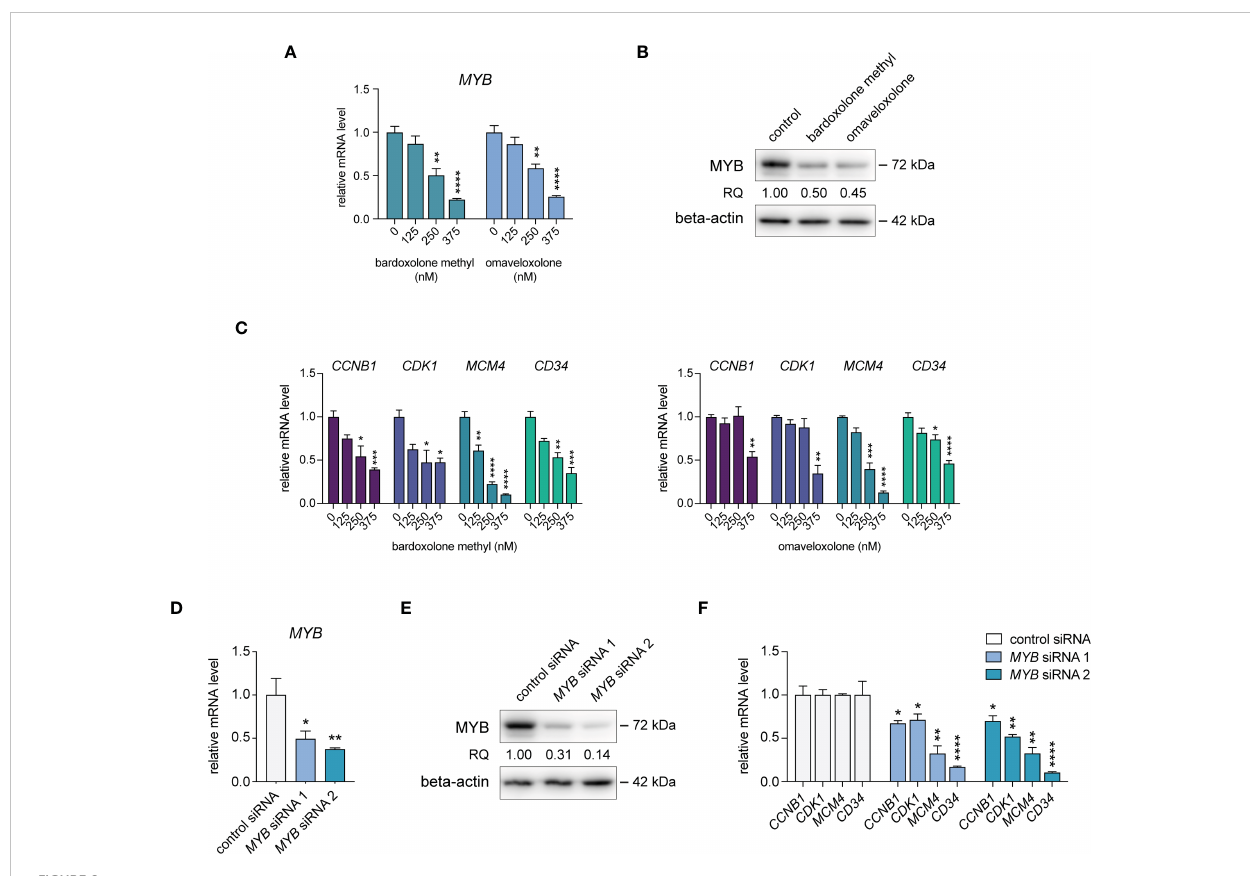
FIGURE 2 Treatment with oleanane triterpenoids (OTs) leads to decreased expression of MYB and its downstream target genes. (A) MYB mRNA expression in MOLT-4 cells treated with bardoxolone methyl and omaveloxolone for 24 h. (B) MYB protein expression in MOLT-4 cells treated for 24 h with 250 nM OTs. (C) Expression of MYB downstream target genes in MOLT-4 cells treated as in (A, D) Knockdown of MYB mRNA in MOLT-4 cells after treatment with 1 µM of MYB siRNAs for 48 h. (E) MYB protein expression in MOLT-4 cells treated with MYB siRNAs as in (D, F) Expression of MYB downstream target genes after MYB knockdown as in D and (E) Error bars indicate standard error of the mean. One-way ANOVA test (* P < 0.05; ** P < 0.01; *** P < 0.001; **** P < 0.0001). Data shown represents one of three independent experiments. RQ, relative quanti fi cation of MYB protein levels normalized with beta-actin